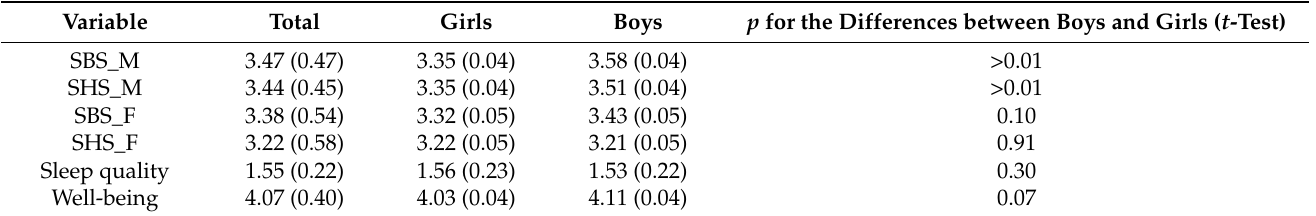
Table 1. Mean scores and standard deviations (in brackets) obtained in the total sample for girls, boys, and for attachment dimensions, sleep quality, and overall well-being. Girls Boys p for the Differences between Boys and Girls ( t